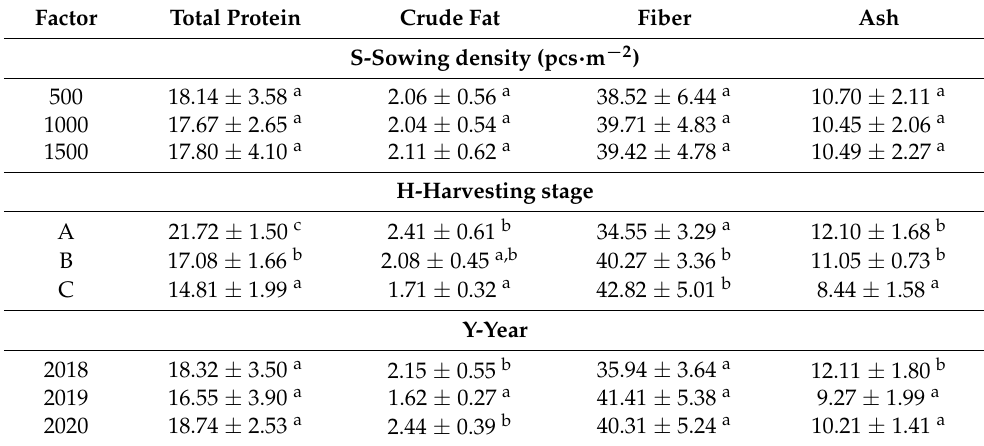
Different growth stages: A—before budding, B—budding, C—full flowering. Results are expressed as mean value ± standard deviations. Different letters in the same column indicate significant differences ( p < 0.05) according to the three-way analysis of variance (ANOVA) followed by Tukey’s